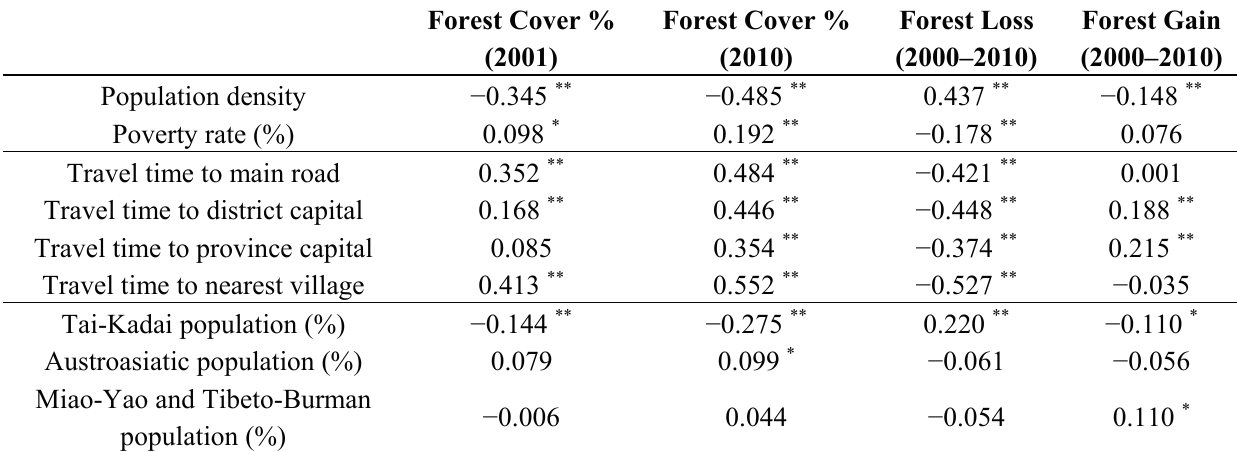
Figure 10. Forest cover change rate in relation with socio-economic variables in the Luang Namtha province (LNP). Table 9. Pearson correlations between forest cover change and socio-economic variables in the Luang Namtha